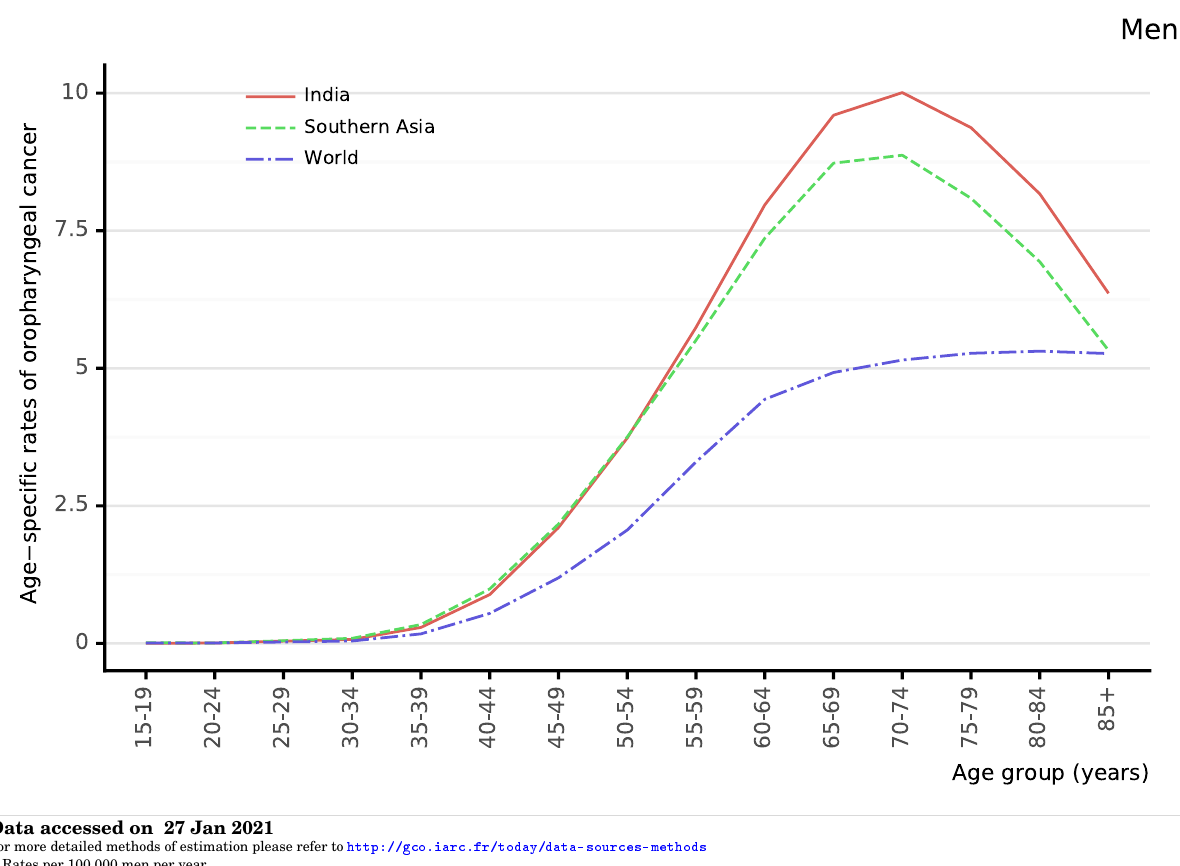
Figure 125: Comparison of age-specific oropharyngeal cancer mortality rates among men by age in India, within the region, and the rest of world